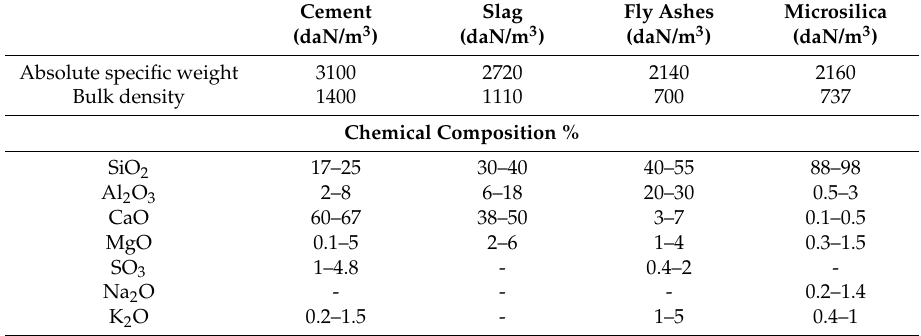
Table 1. Properties and chemical composition of the materials utilized in the concrete